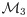
Extrapolated infection trajectory for grand average over 40 countries obtained from the model M3.Grey dots are historical infection trajectories for 40 countries spanning from January 22nd to May 14th. Posterior means for the flat time points are tflat,γ=0.999 = July 5th and tflat,γ=0.9999 = July 31st.